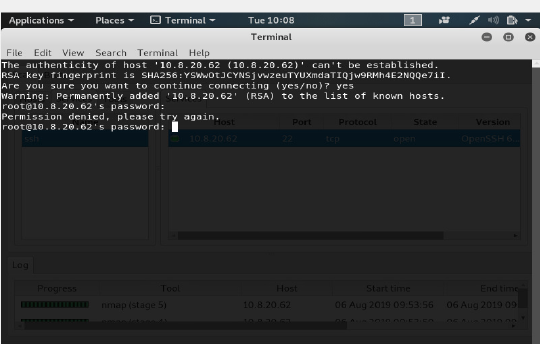
Fig. 15: Open with Telnet Attack (Protocol Mismatch)